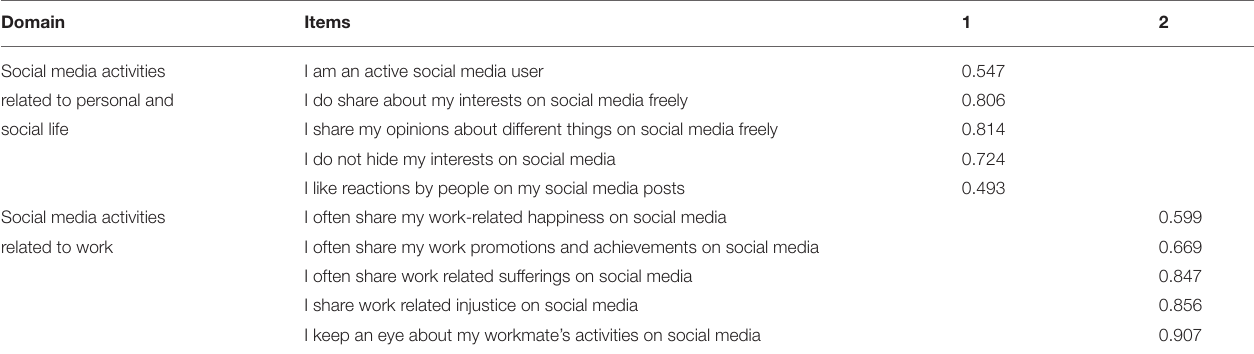
TABLE 3 | Factor loadings by EFA of Social media activity.